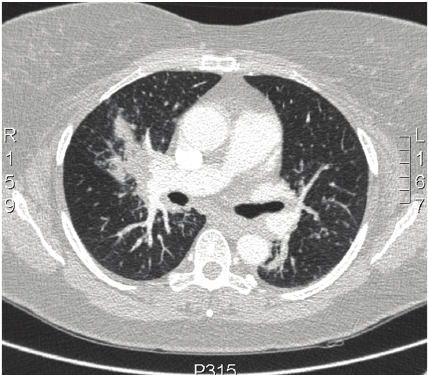
Figure 2: HRCT of the thorax after discontinuation of infliximab showing increased consolidation and nodular abnormalities.